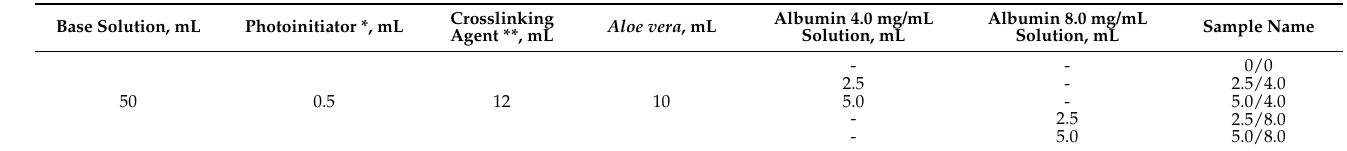
Table 1. Compositions of hydrogel